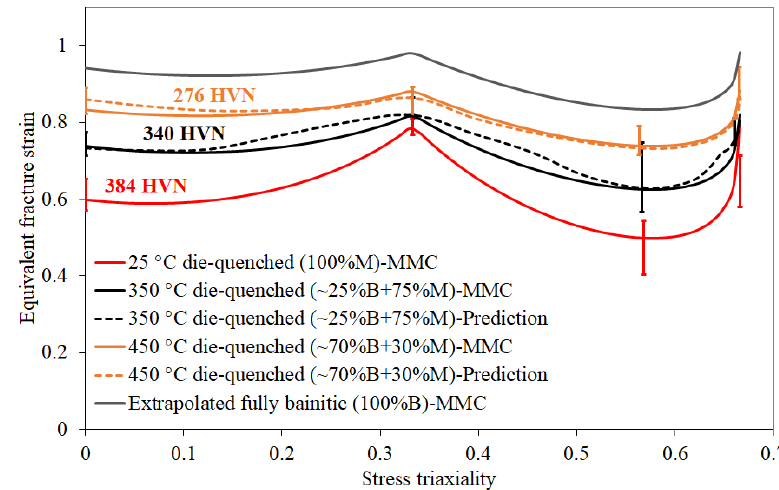
Figure 21. The predicted fracture loci of the reference multi-phase microstructures of Ductibor ® 1000-AS using the established numerical scheme compared with their MMC fracture curves. The 100%B and 100%M fracture loci are also shown for comparison purposes. The scatter of the measured data is denoted by the error bars.